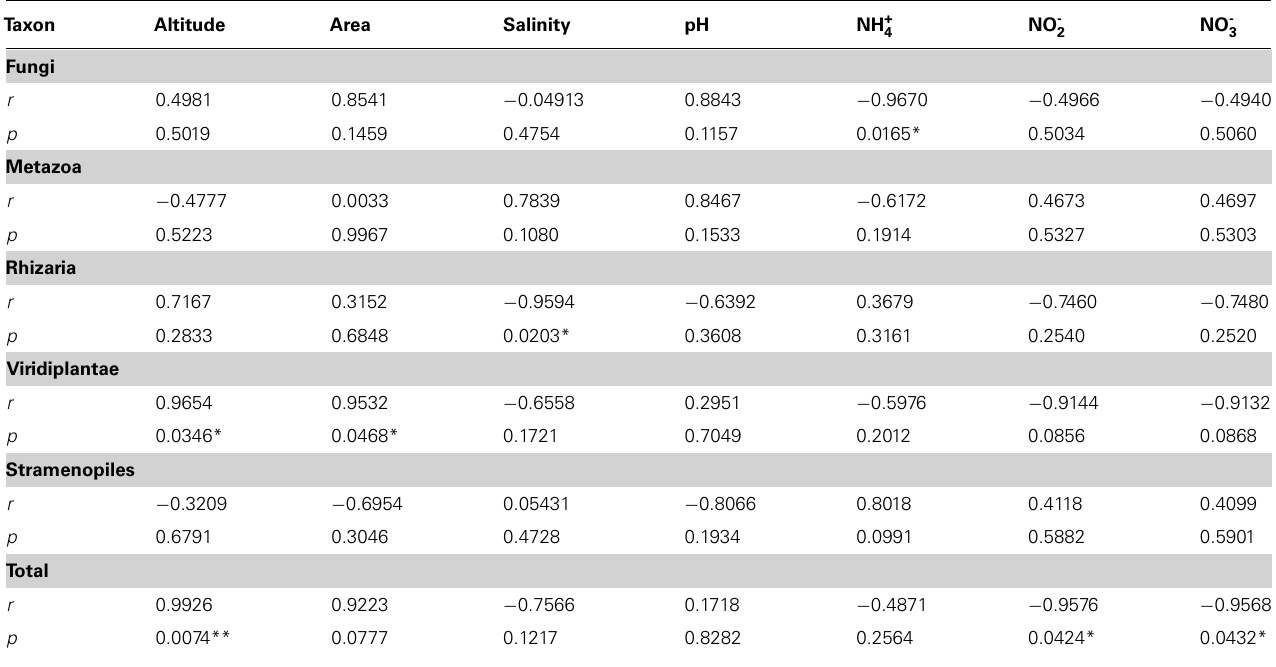
Table 5 | Correlation analysis between taxa of small eukaryotes from glaciers and environmental variables.